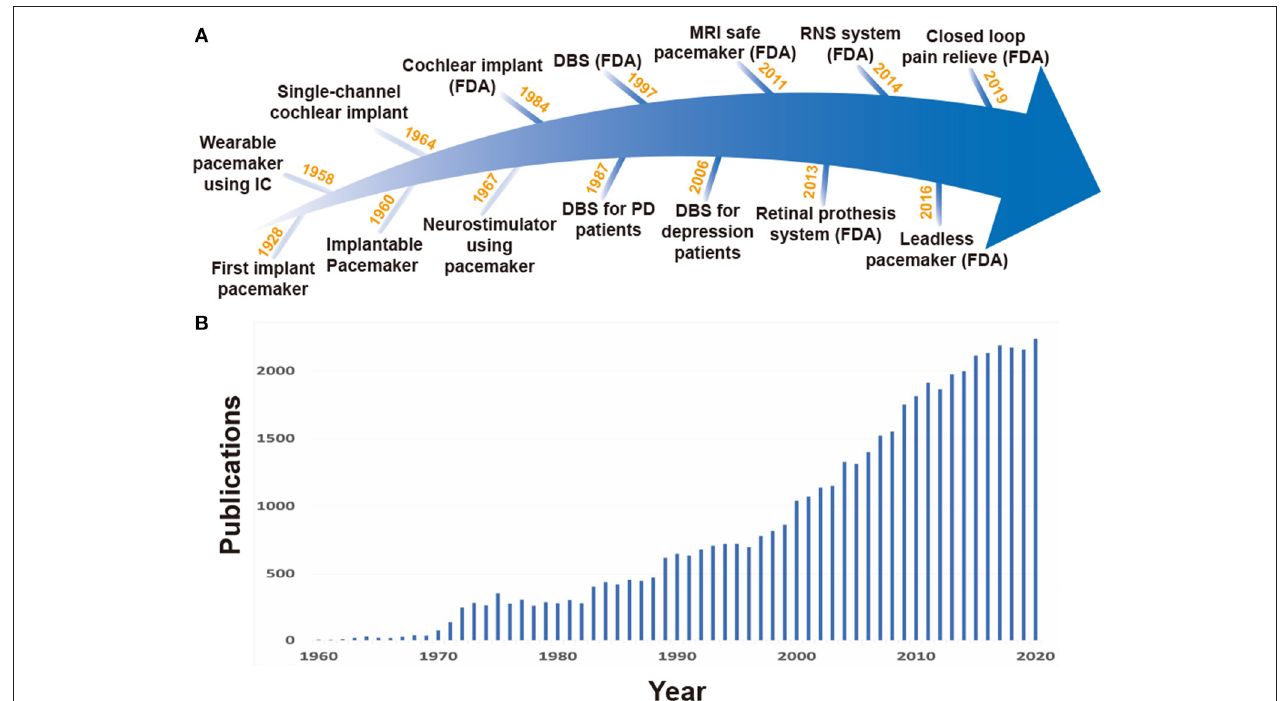
FIGURE 1 | (A) History for stimulation devices. (B) Rapid increase in the number of publications on implantable stimulation devices, searched at PubMed (http://www.